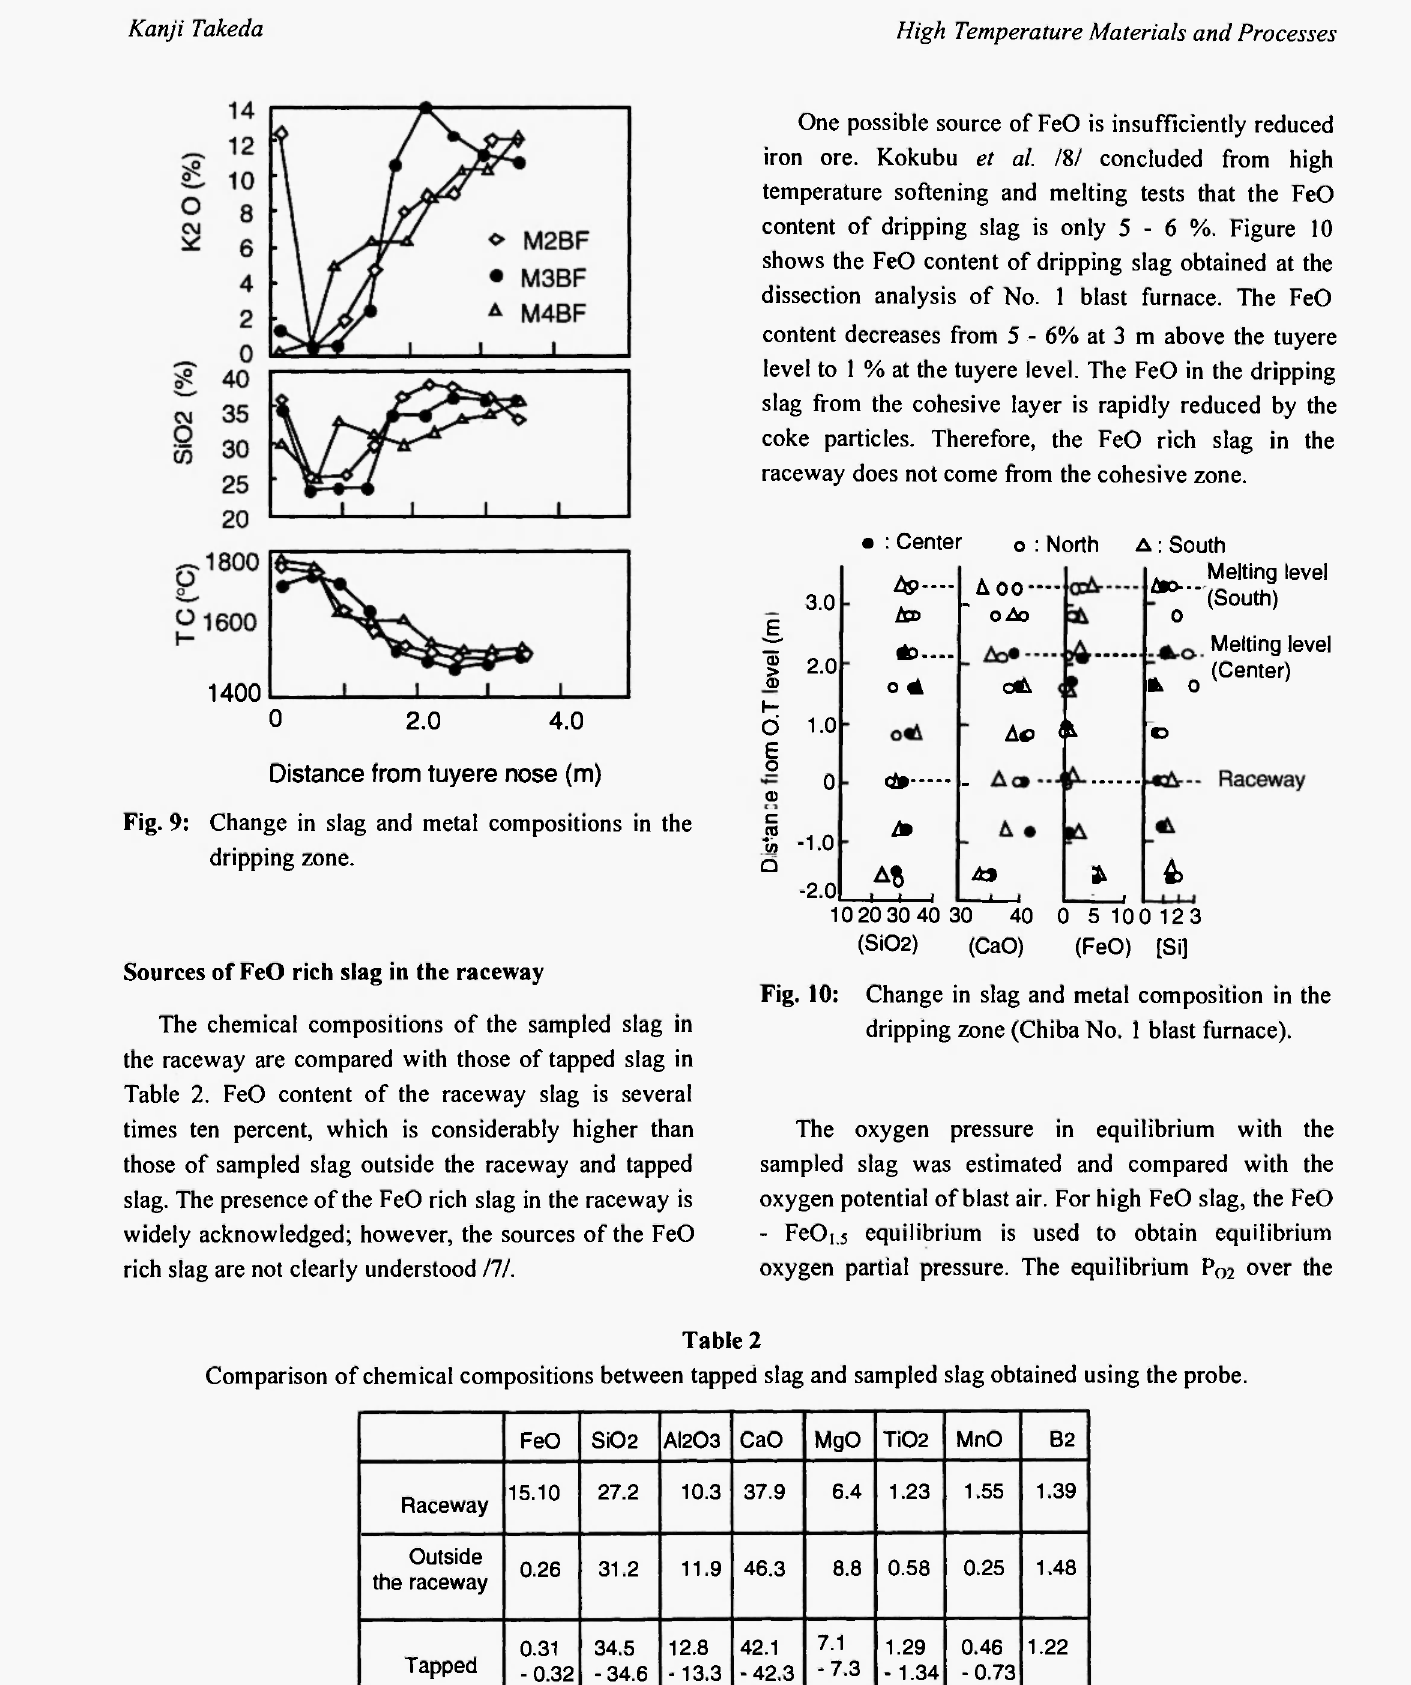
Comparison of chemical compositions between tapped slag and sampled slag obtained using the